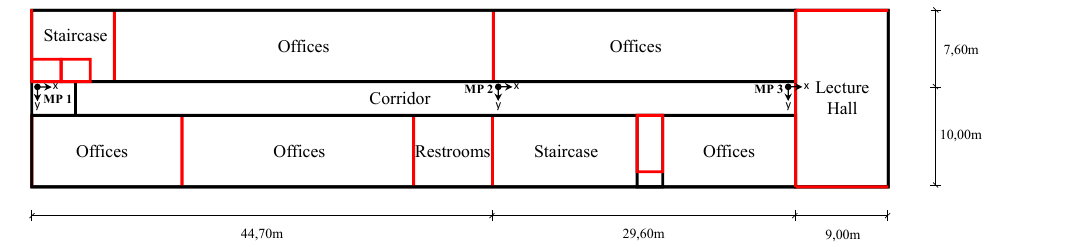
Figure 4. Floor plan of the story 6 of the RC-building.